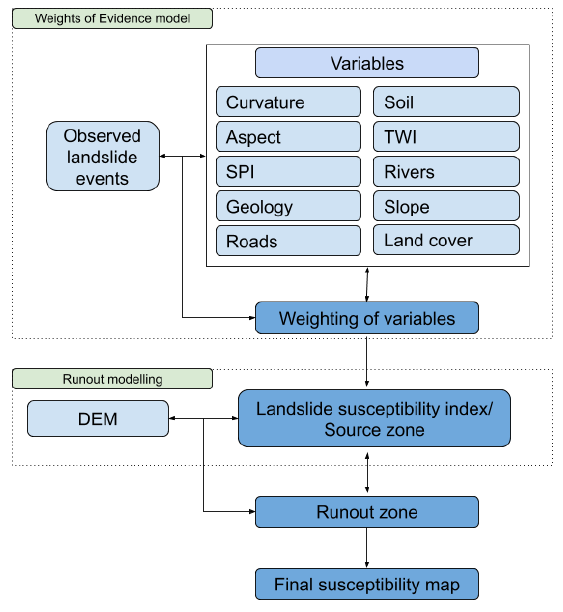
Figure 2. Flowchart of modelling landslide susceptibility.